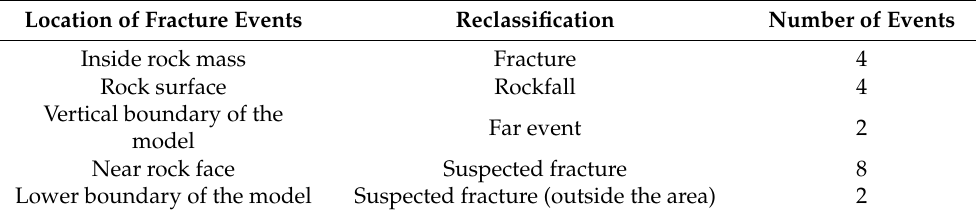
Table 2. Summary of the location results for 20 fracture